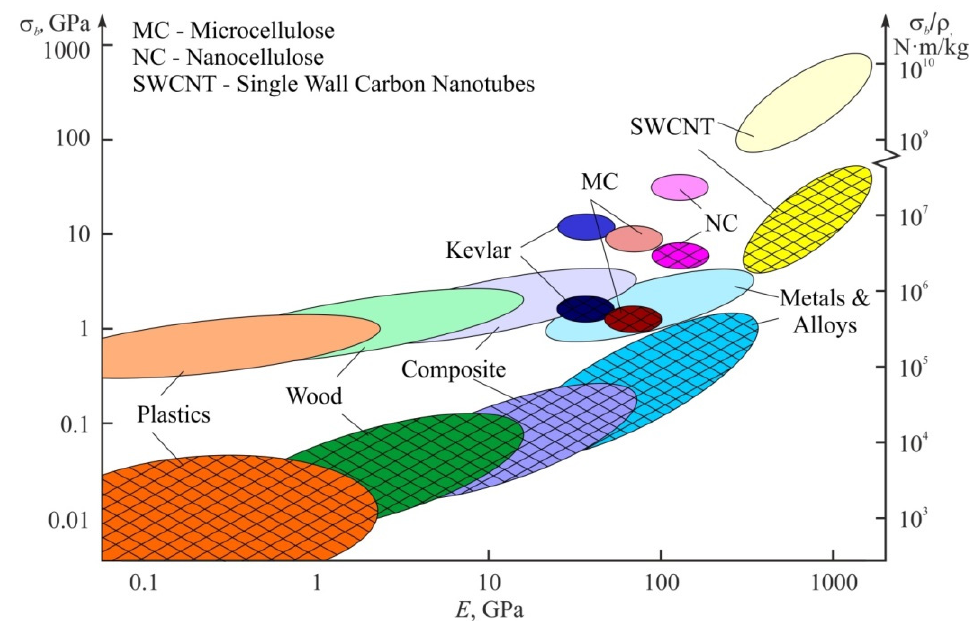
Figure 8. Mechanical properties of nanocellulose (NC) and cellulose microfibers (MC) in comparison to common and perspective constructional materials. Crosshatched areas denote absolute values of tensile strength σ b , while non-crosshatched ones are the strength normalized over material density ρ .